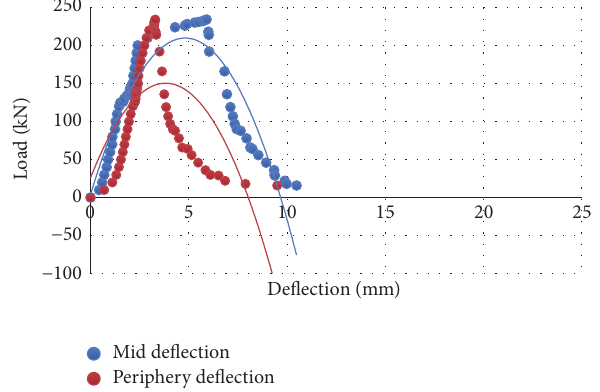
Figure 9: Punching shear values for 1.5% of steel fibre (GCF23).